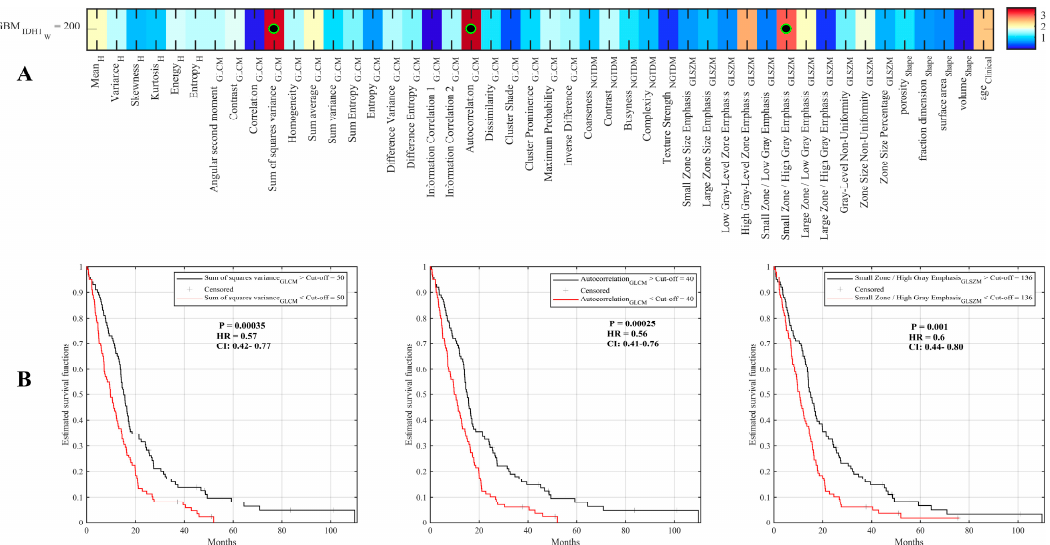
Figure 1. Univariate prediction of survival using radiomic features ( A ) Log-rank significance of survival difference between separated by individual radiomic features. ( B ) Kaplan–Meier survival curves for “autocorrelation”, “sum square variance” and “small zone/high gray emphasis”.